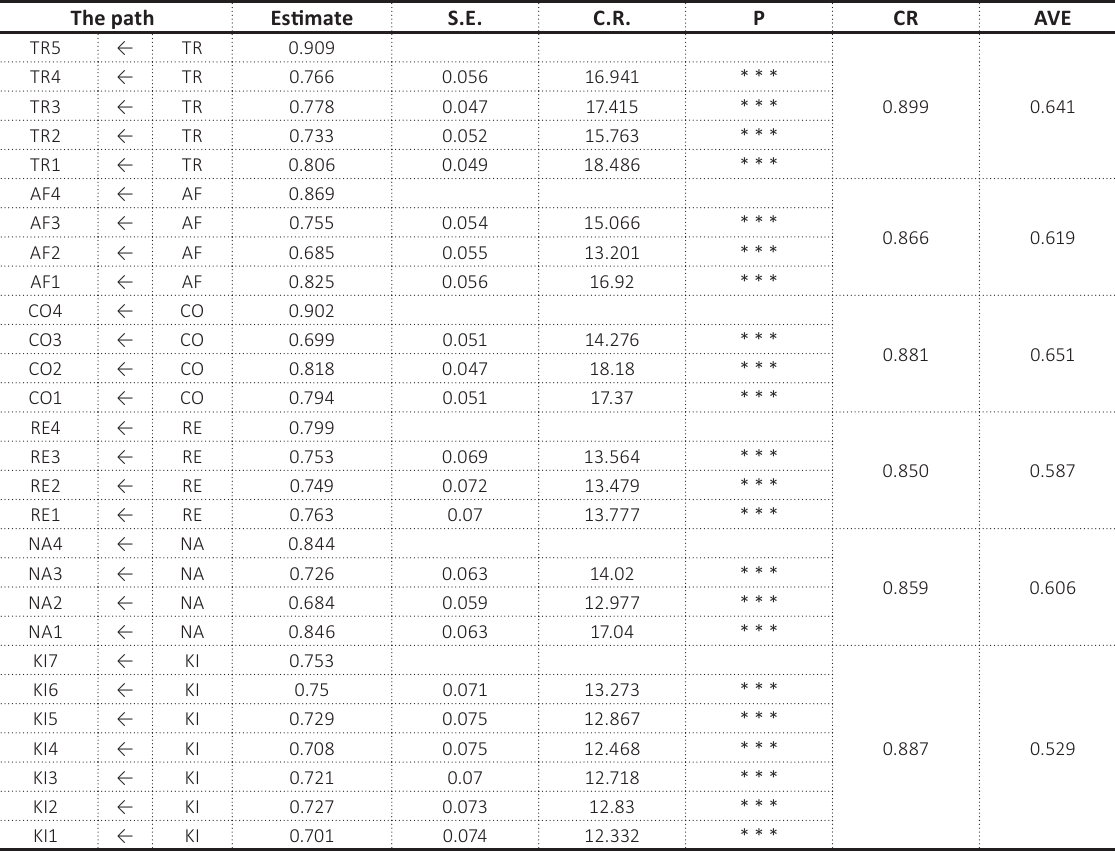
Table 5. Confirmatory factor analysis The path Estimate